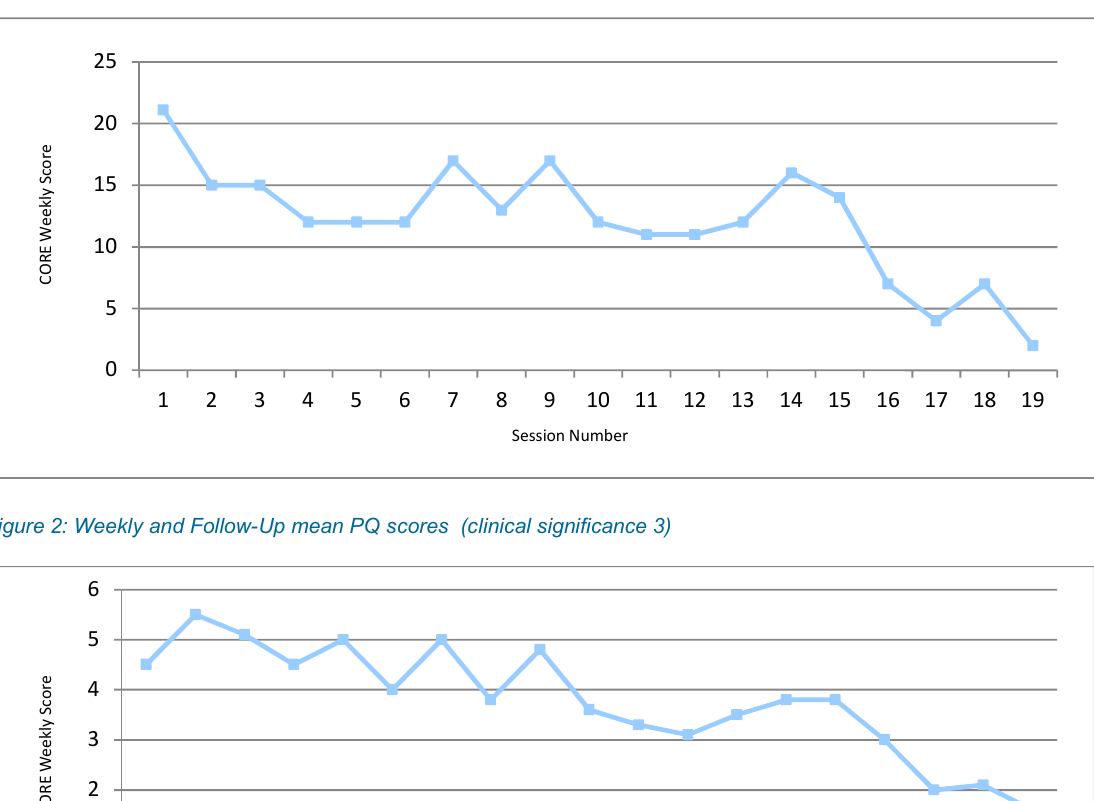
Figure 1: Weekly and Follow-Up CORE-10 scores (clinical significance 10)